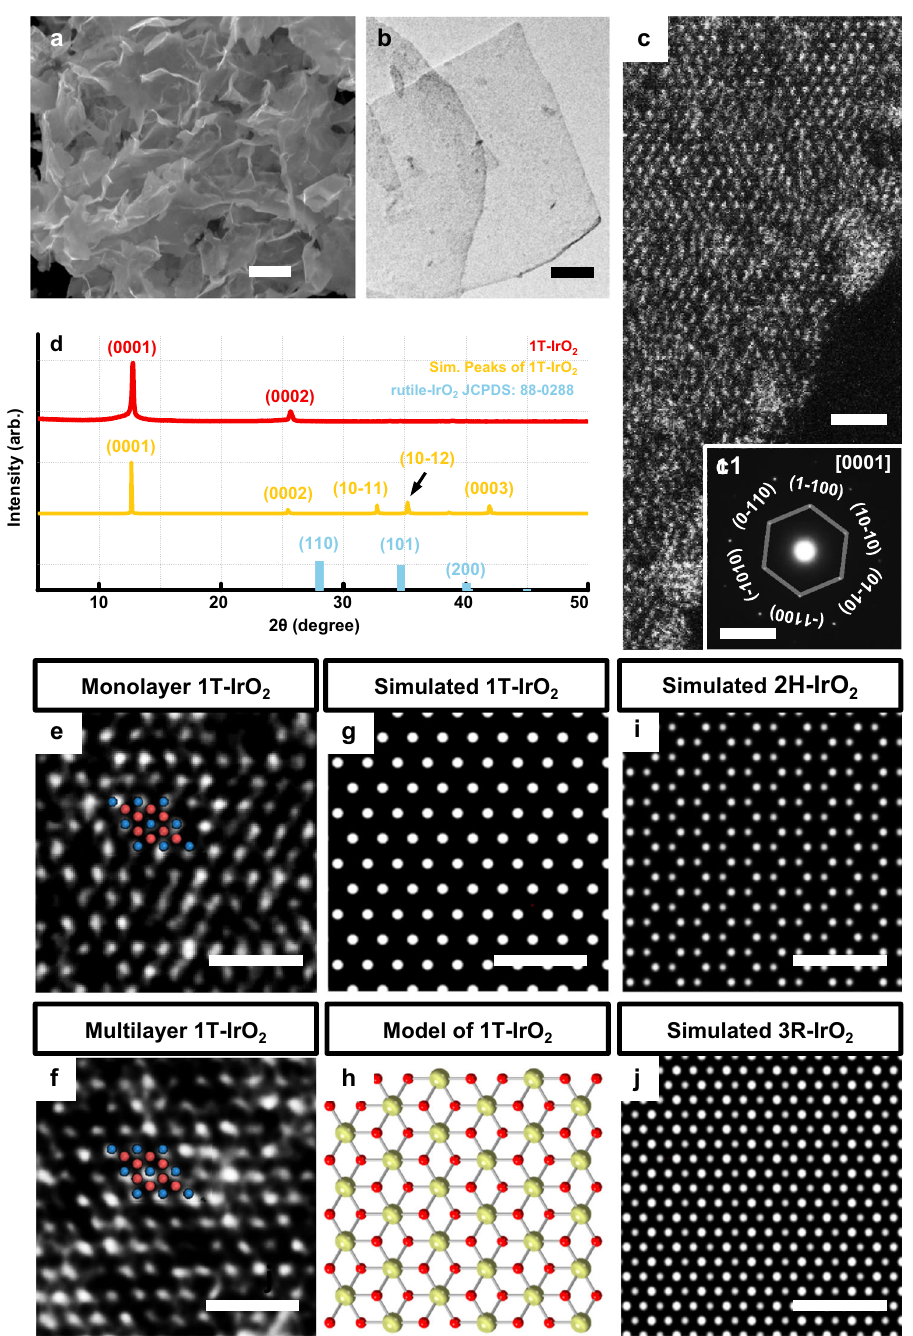
Fig. 2 Structural characterizations of 1T-IrO 2 . a The SEM and b TEM images of 1T-IrO 2 , representing ultrathin morphology. c The aberration-corrected HAADF-STEM image of monolayer 1T-IrO 2 . The hexagonal pattern is indicative of the [0001] projection. c1 The SAED pattern of 1T-IrO 2 in Fig. 2c, showing the six-fold rotational symmetry. d Comparison of XRD patterns of 1T-IrO 2 (red curve), simulation X-ray diffraction peak (yellow curve) of 1T-IrO 2 and the rutile-IrO 2 (blue line) (JCPDS No. 88-0288). The XRD measurement showing high orientation of the layered structure of 1T-IrO 2 along the c -axis. e, f HAADF-STEM images of the monolayer and multilayer 1T-IrO 2 , which show identical atom arrangement. Ir and O are represented by blue and red spheres. g, i, j Simulated TEM images of IrO 2 with 1 T, 2H and 3 R phases. Our result of 1T-IrO 2 is in accordance with the AA stacking, different from those shown by AB stacking (2H) and ABC stacking (3 R). h The atom model of 1T-IrO 2 , where the yellow and red balls are Ir and O. The scale bars in a, b, c, and c1 are 2 μ m, 100 nm, 1.25 nm, and 5 1/nm, respectively. The scale bars in e, f, g, i, j are 1